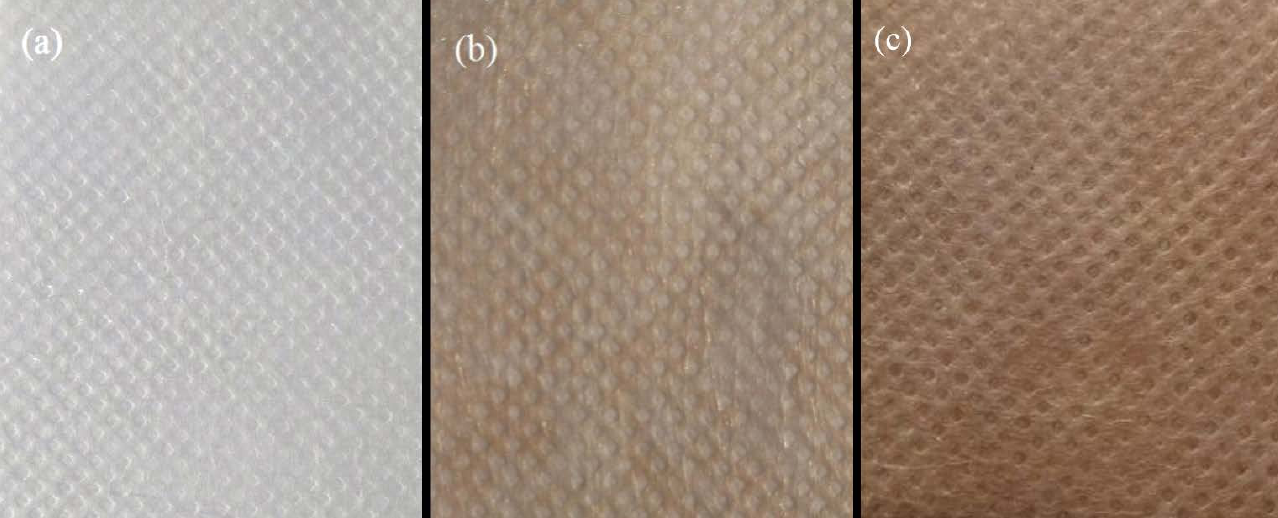
Figure 3. Optical photographs of PLA nonwoven fabrics: ( a ) original PLA (control); ( b ) CS-Ag NPs PLA; ( c ) DBD CS-Ag